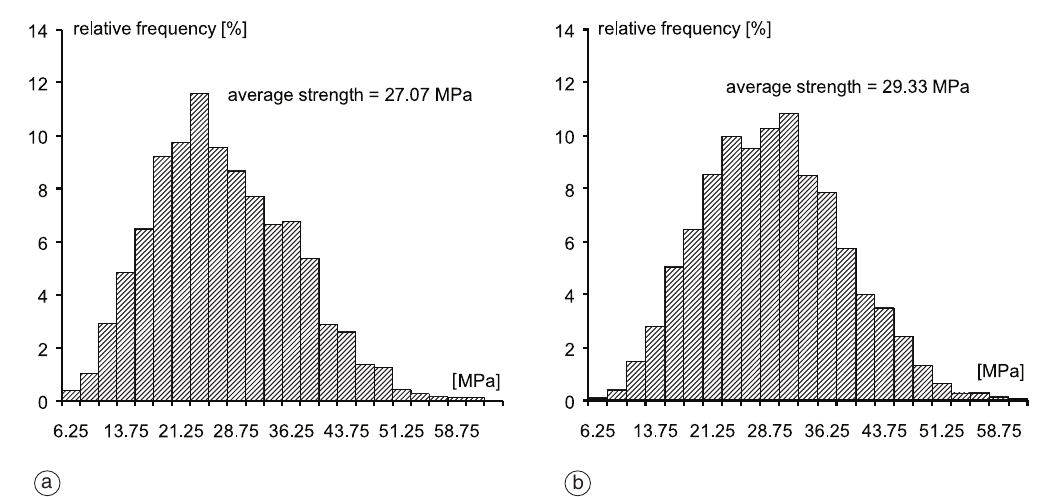
a b Fig. 3a,b. Concrete strength distribution (a) for the year 1960 and (b) for the decade 1960-1970.